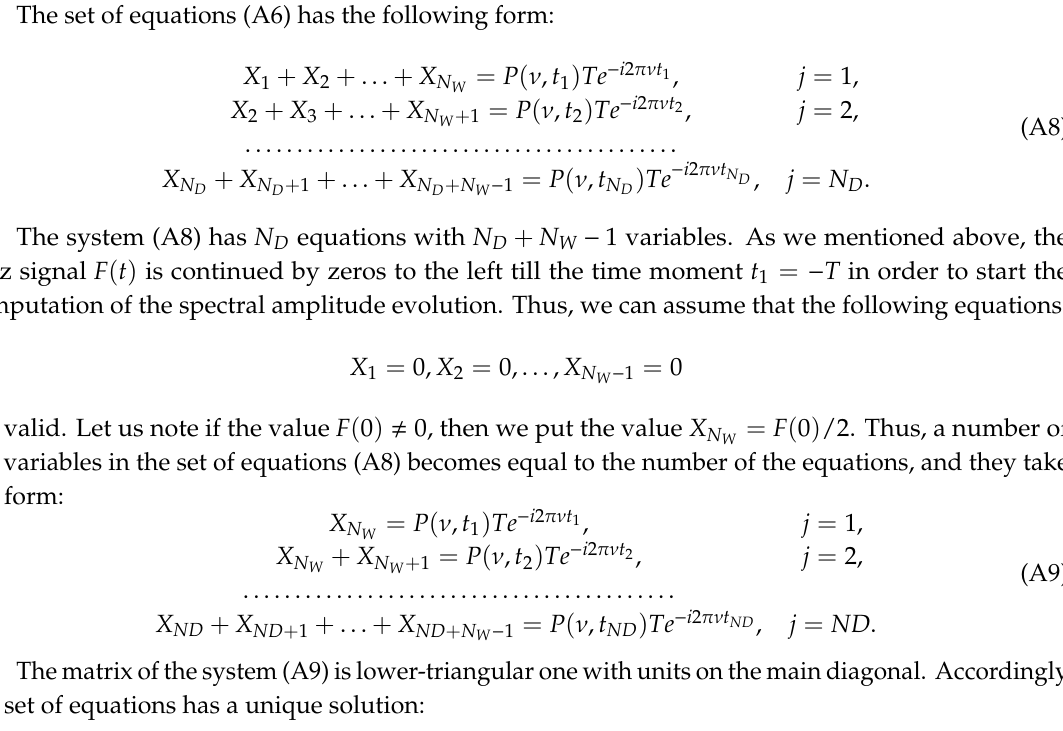
Figure A1. Schematic representation of window length T = 10 ps moving along the 2,4-DNT signal with window shift Δ = 5 ps in the time interval t = [0, 20] ps.